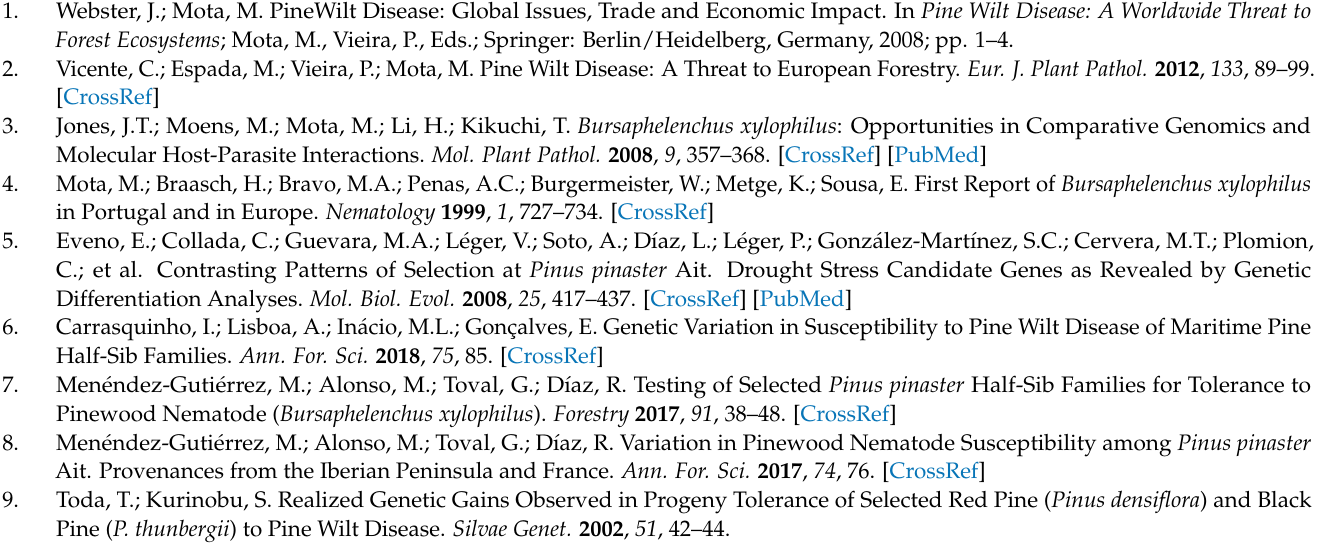
Supplementary Table S5. Allele frequencies and Hardy–Weinberg Equilibrium significance values calculated by SNPassoc; Supplementary Table S6. Non-significant results of the haplotype association analysis obtained with SNPassoc. All analyses were performed using a logistics regression